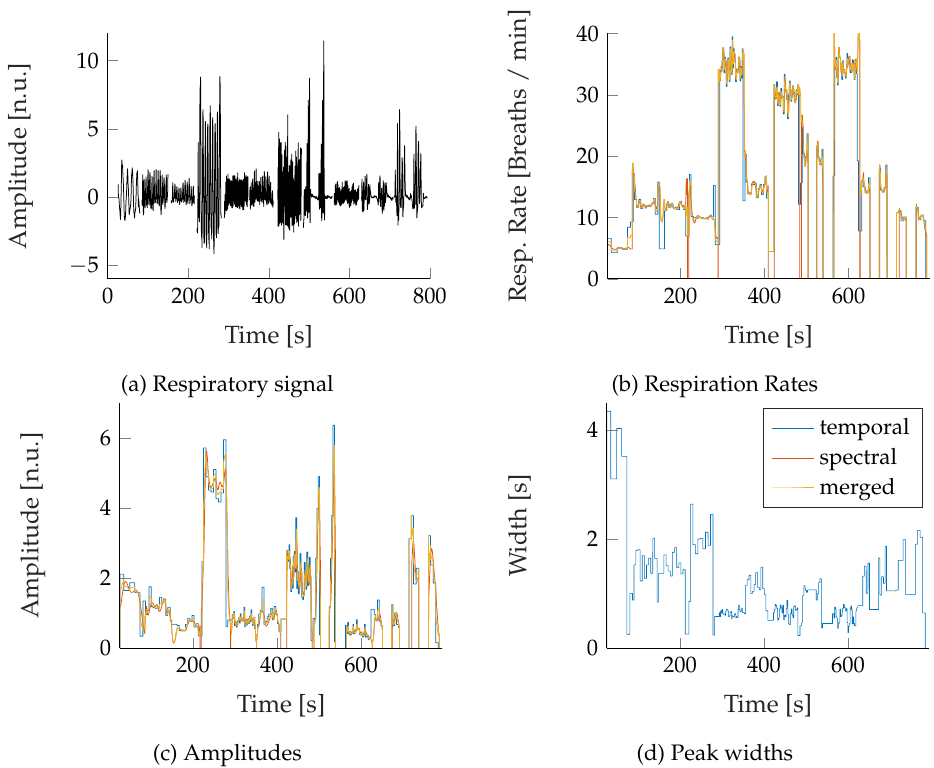
Figure 9. Time progression of the extracted features of an exemplary signal (RGB video of subject 6). All spectral, temporal and robustly merged features are